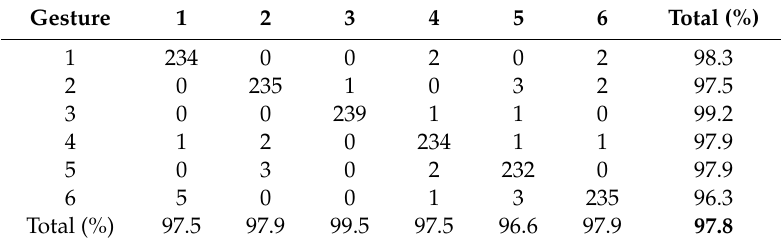
Table 3. Comparison results for all subjects.